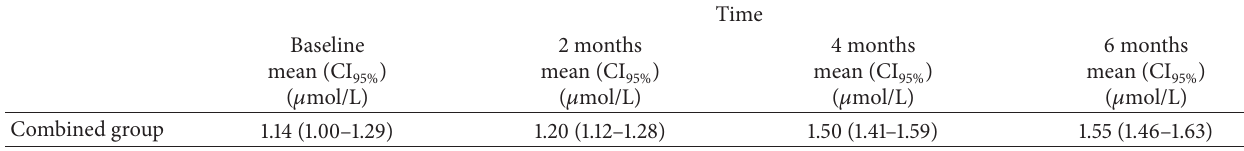
Table 6: Estimated ∗ mean serum retinol in combined group, during followup, Recife,